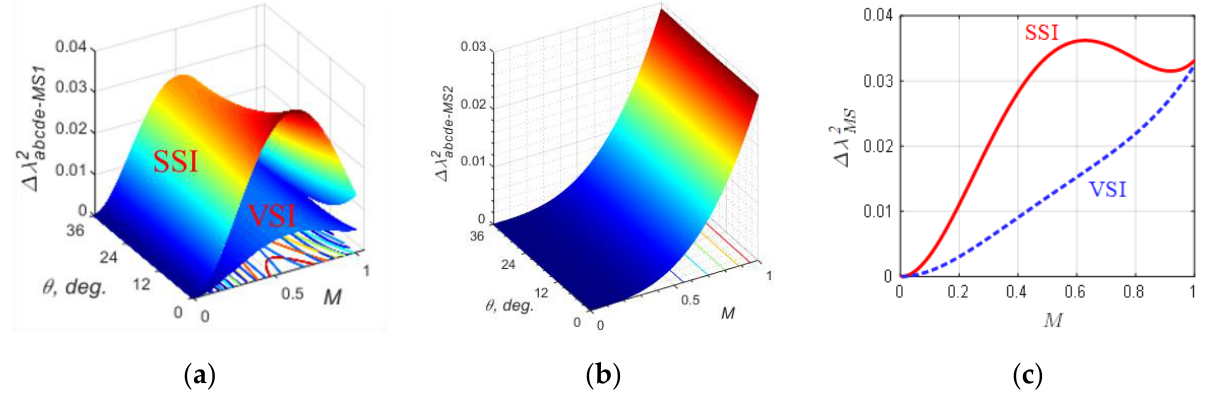
Figure 15. Error-voltage vector and harmonic-flux trajectory during the half of the switching cycle for VSI and SSI [26].